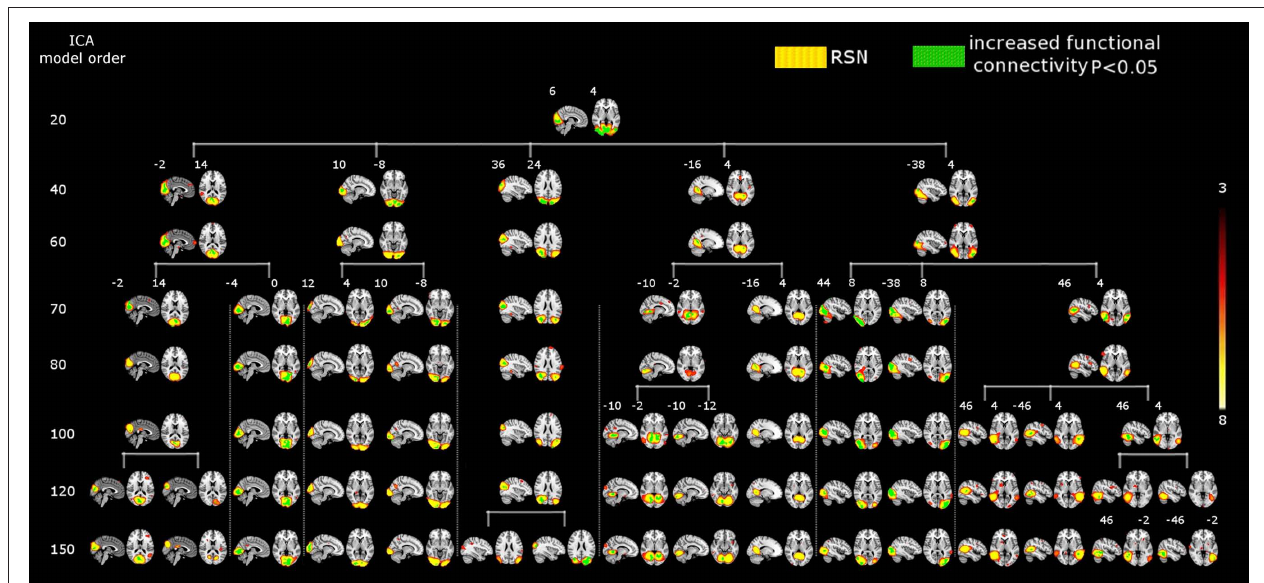
fine-grained segmentation. A prominent increase in the number of sub- networks (red–yellow) with significant increased connectivity is evident at higher model orders. Numbers at the bottom of the images refer to MNI coordinates (xyz). The left hemisphere corresponds to the right side and t-score threshold is shown at the